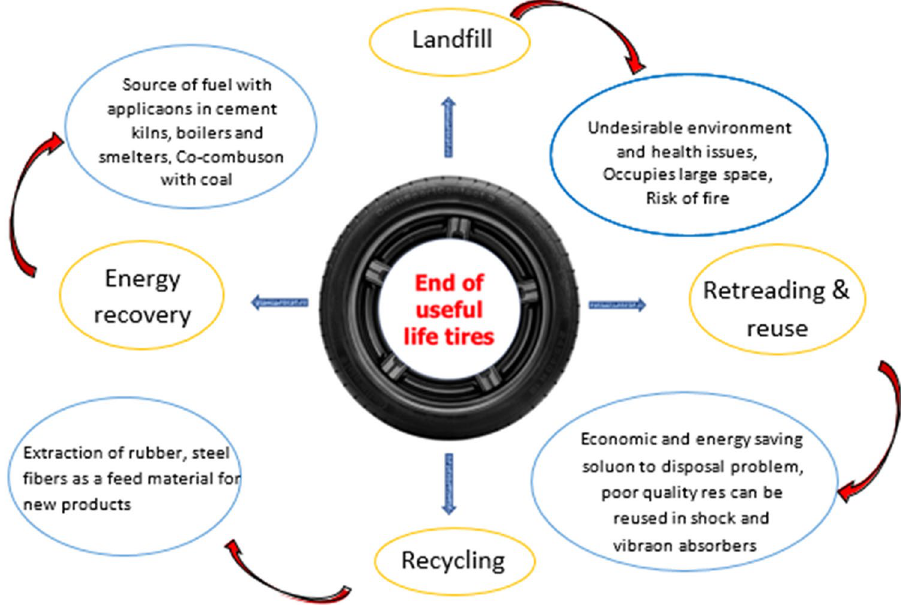
Fig. 1 End-of-life tires manage- ment strategies